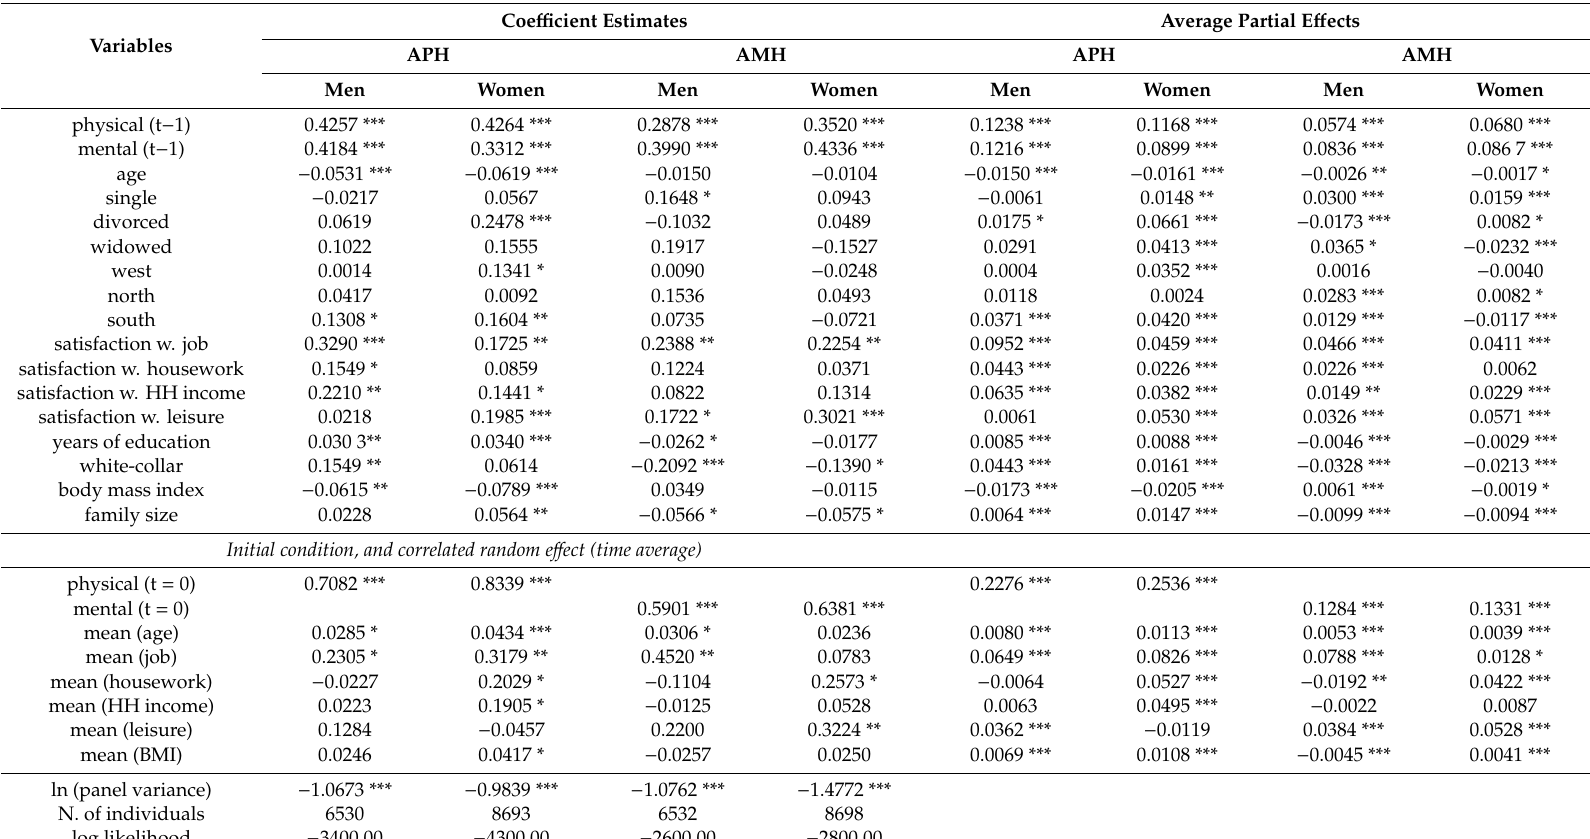
Table 3. Estimation results: aggregate